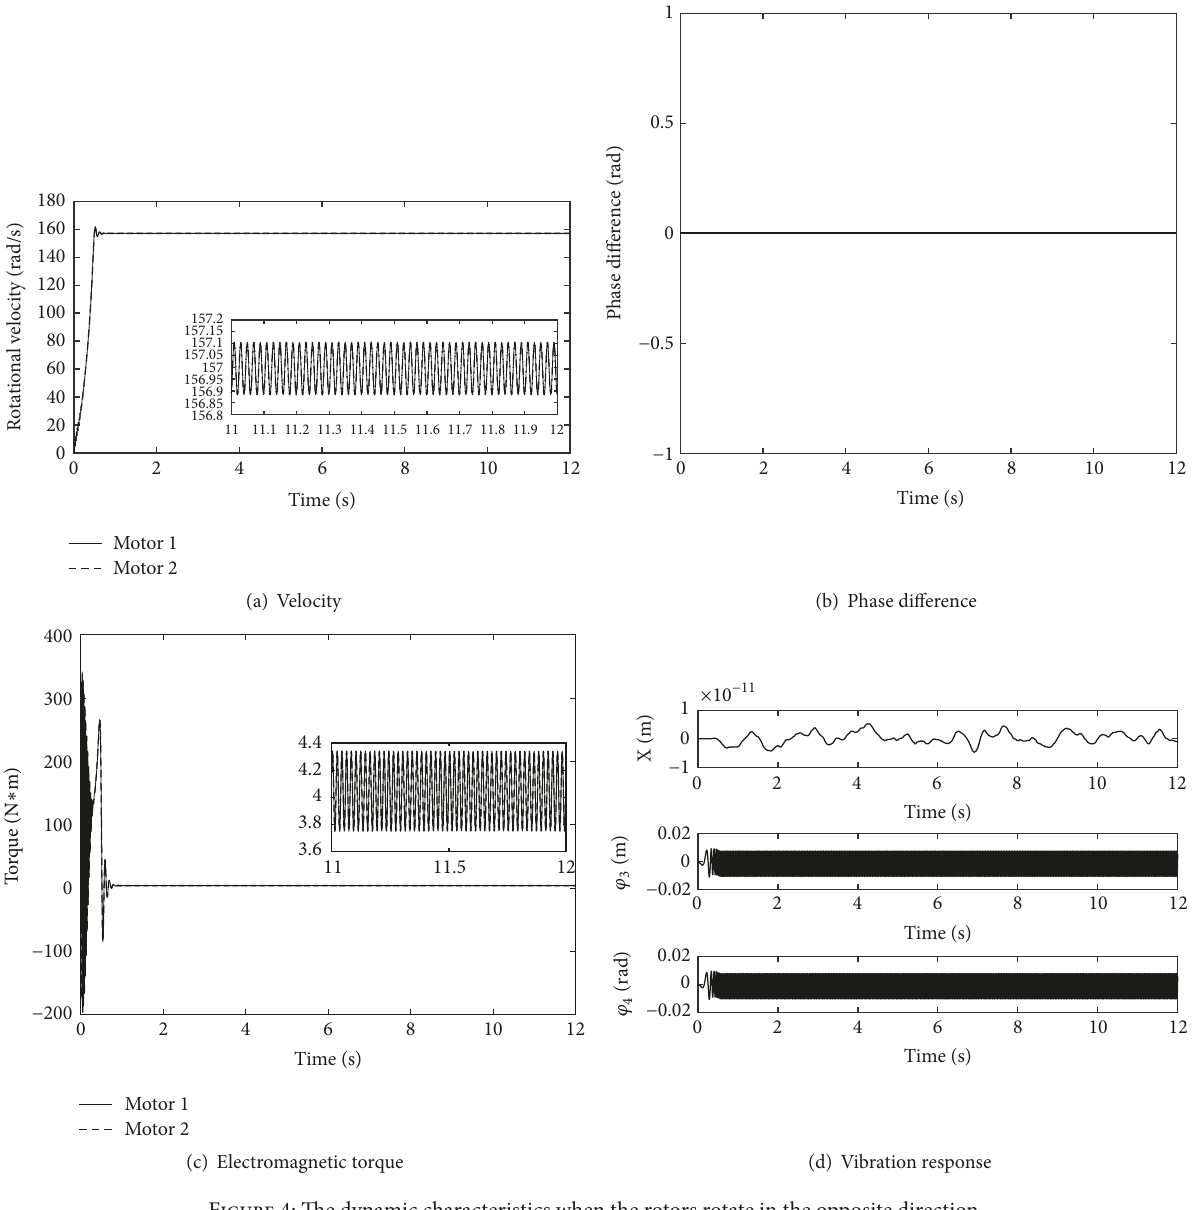
Figure 4: The dynamic characteristics when the rotors rotate in the opposite